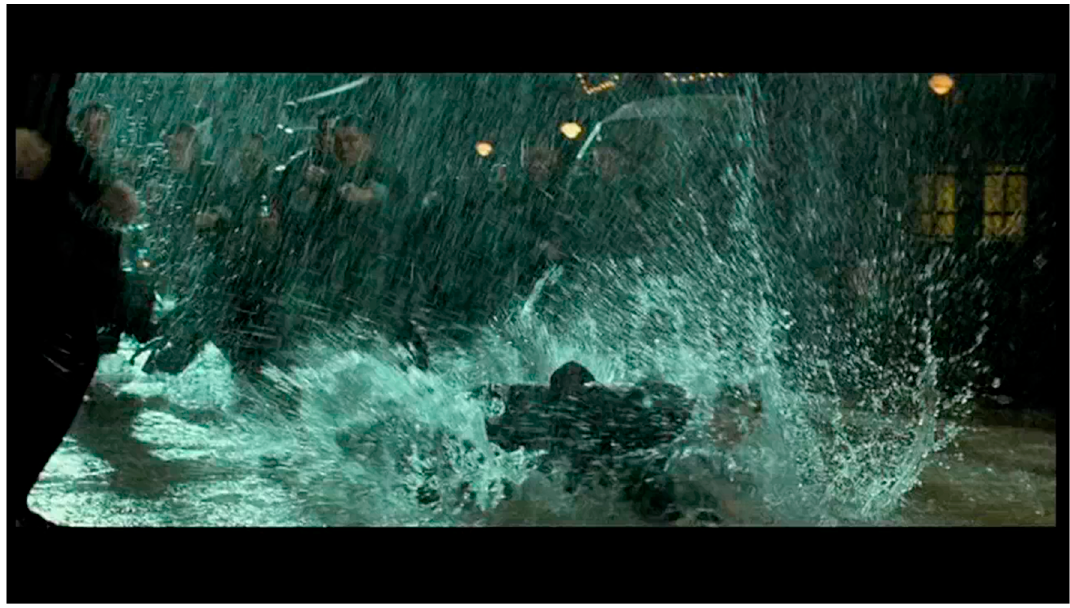
Figure 13. Body/movement images interact with their environment in terms of mutual performance. Frame capture, The Grandmaster (Wong 2013).